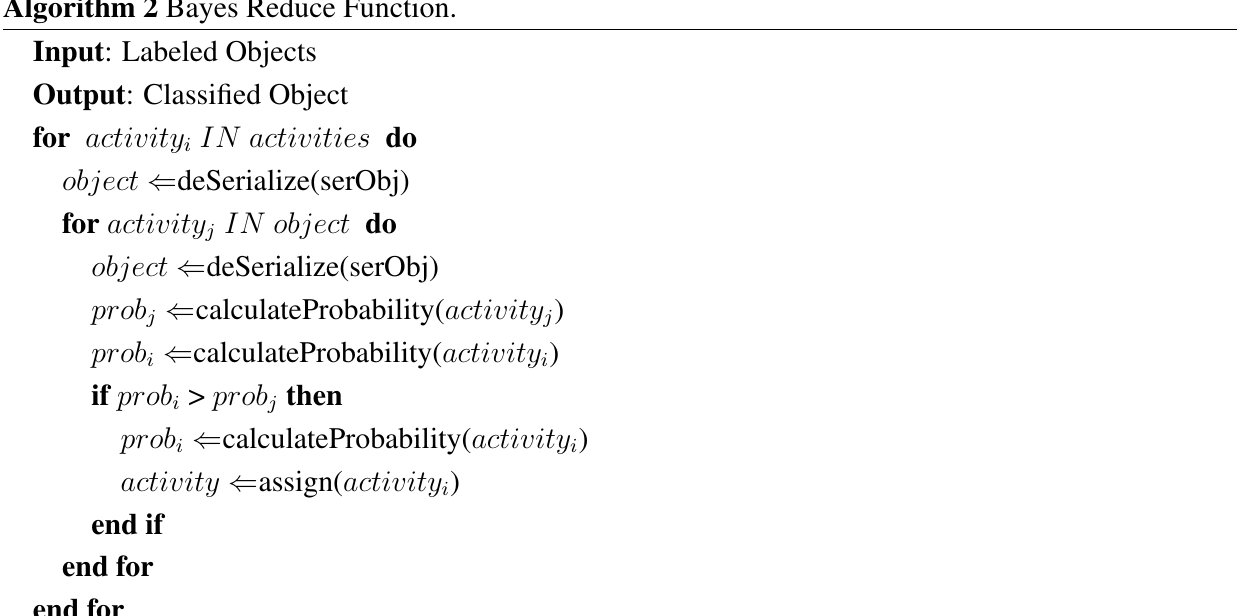
Algorithm 2 Bayes Reduce